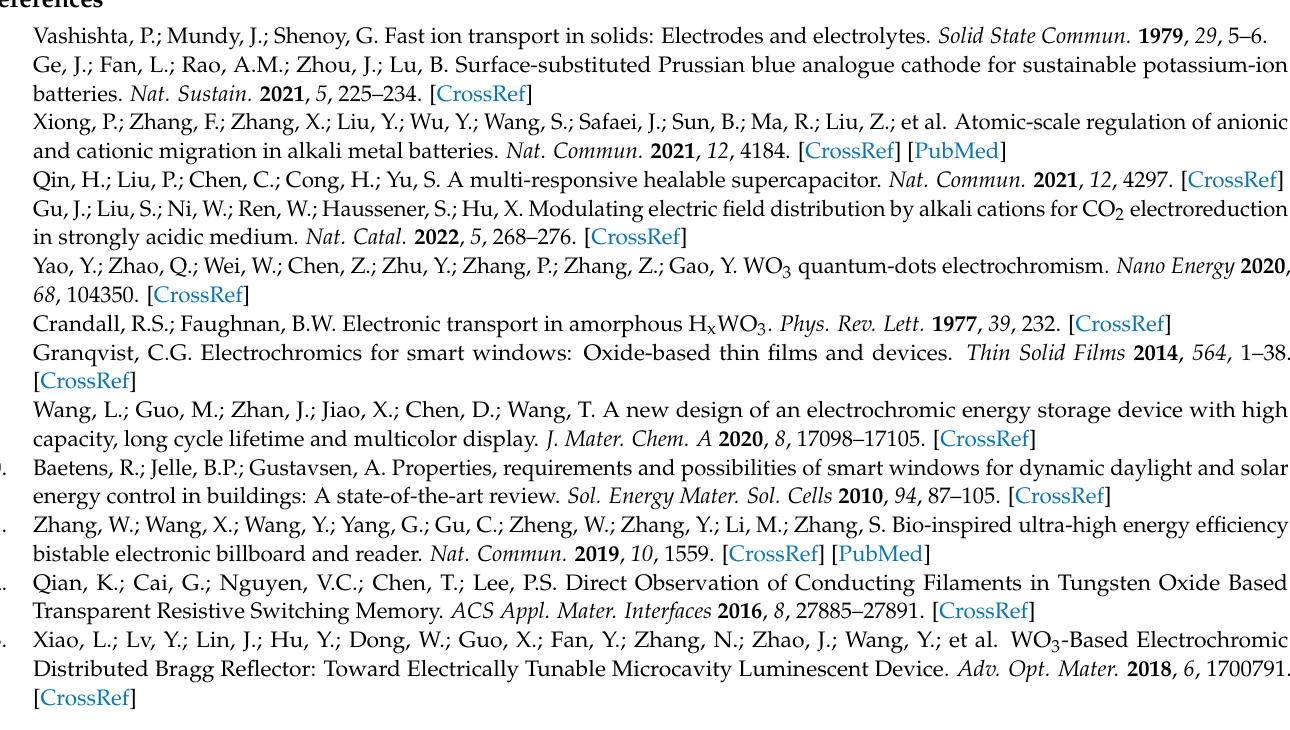
WO 3 film during 5000 CV cycles at scanning rates ranging from 0.01 to 0.1 V/s versus Ag/AgCl, a the first cycle; b the 1000th cycle; c the 2000 th ; d the 3000th cycle; e the 4000th cycle; f the 5000th cycle; Figure S8: CV curves of the 100W-deposited WO 3 film during 5000 CV cycles at scanning rates ranging from 0.01 to 0.1 V/s versus Ag/AgCl, a the first cycle; b the 1000th cycle; c the 2000th cycle; d the 3000th cycle; e the 4000th cycle; f the 5000th cycle; Figure S9: Evolution of the redox peaks versus square root of the scanning rate, a in bleaching process of the 50W-deposited film; b in coloring process of the 50W-deposited film; c in bleaching process of the 100W-deposited film; d in coloring process of the 100 W-deposited film. Author Contributions: Z.Z. and X.T. was responsible for the study design; data analysis;